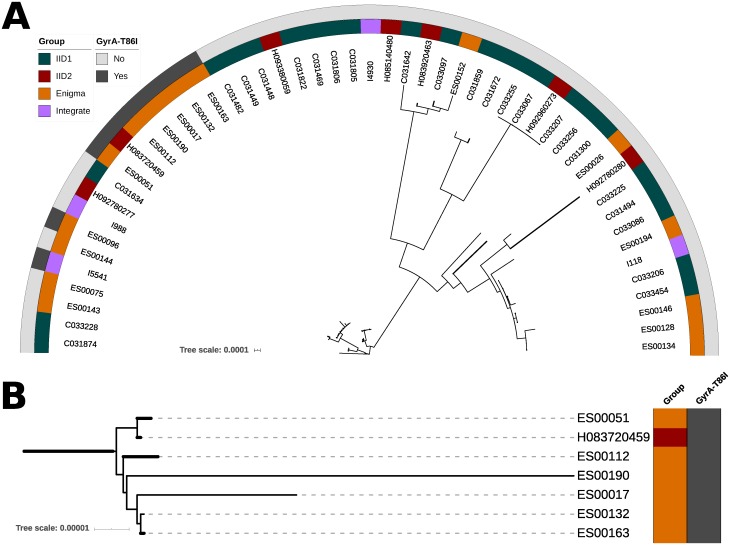
Phylogenetic tree of C. jejuni ST-21 isolates (n = 51) carrying the T86I mutation.(A) Inner ring identifies the study and outer ring identifies isolates carrying the GyrA T86I mutation. (B) Close up of a cluster of isolates mostly from the ENIGMA study. The tree is based on core genome SNP differences. Within this sub-set of isolates, there were 12,265 variant nucleotides.